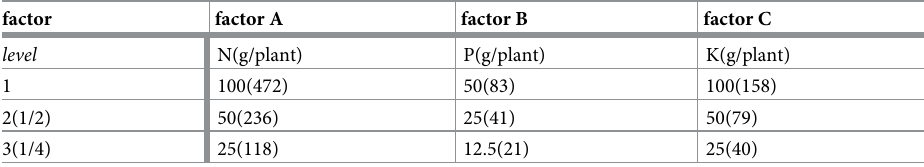
Table notes Data in parentheses are compound dosage g/plant.